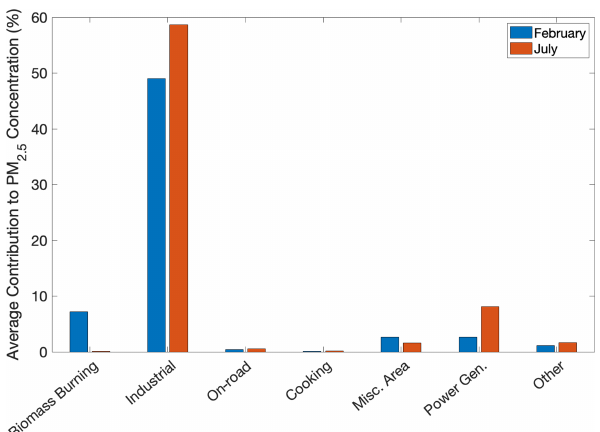
Figure 10. Relative contributions of local sources to average pre- dicted PM 2 . 5 concentrations at the location of highest average con- centration (Beaver County) during February and July 2017.